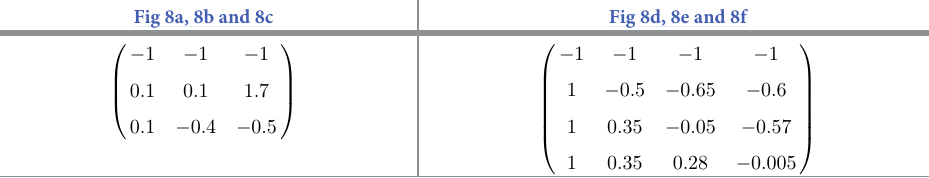
Table 1. Parameters of the models in Fig 8. Matrix A defining the rate model for the different examples in Fig 8. Fig 8a, 8b and 8c Fig 8d, 8e and